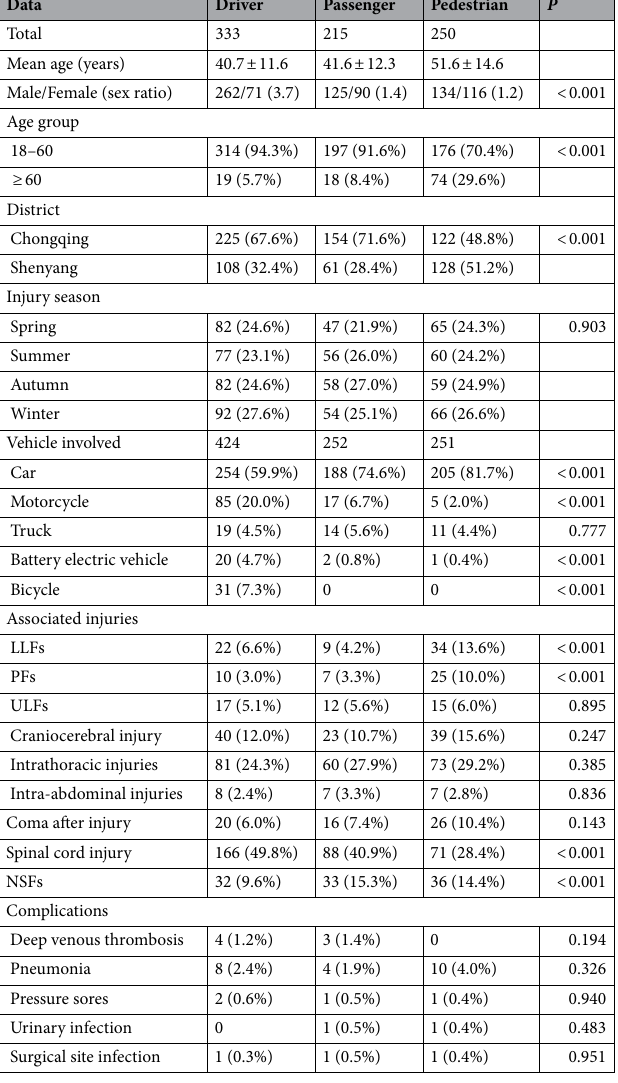
Table 3. Role differences in TSFs caused by